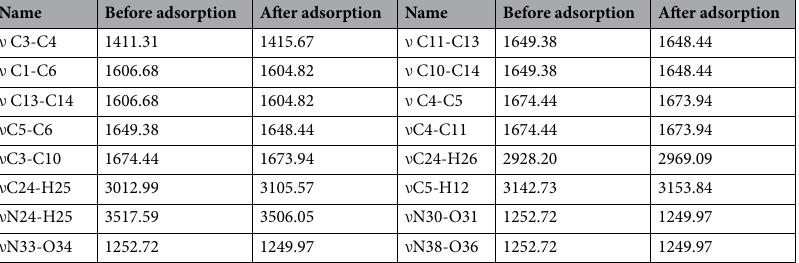
Table 3. Bonding angles of three NO 2 molecules on coal surface side chains.